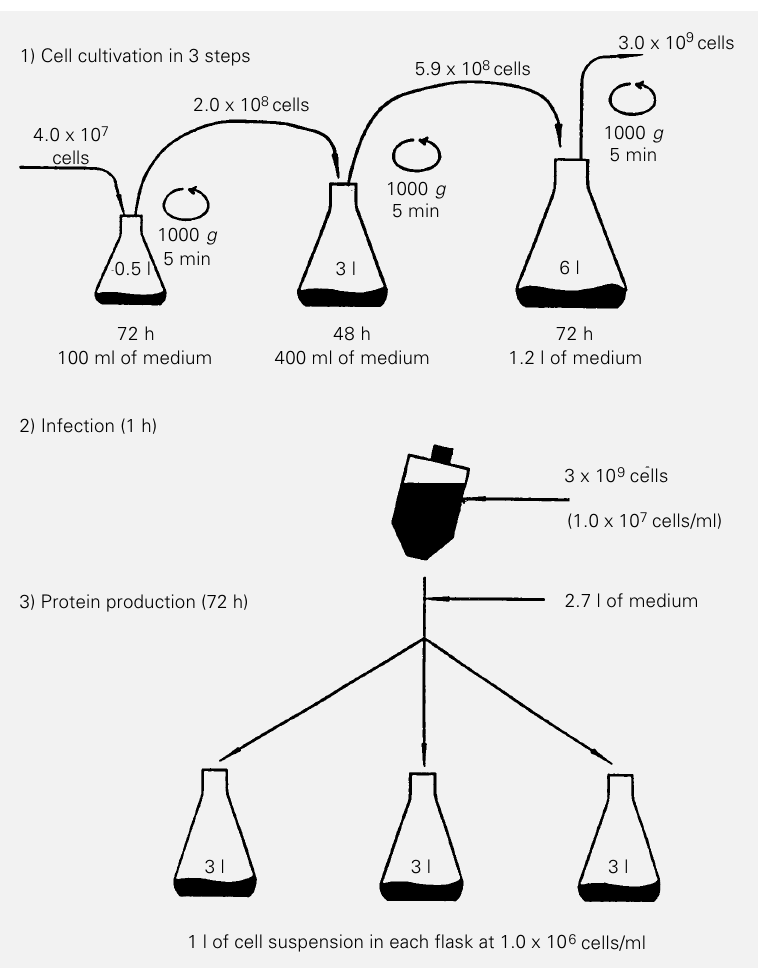
Figure 1 - Schematic outline of the protocol for cell cultivation/infection and protein produc- tion in Erlenmeyer